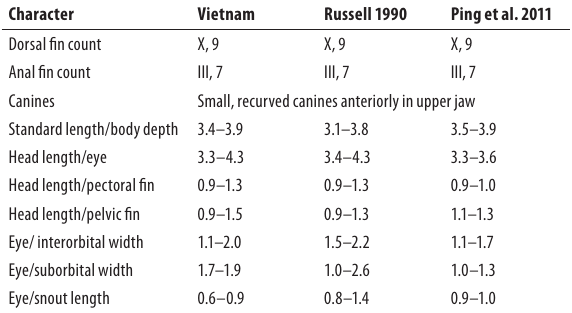
Table 1. Comparison of Nemipterus marginatus specimens from Vietnam with the descriptions by Russell (1990) and Ping et al.